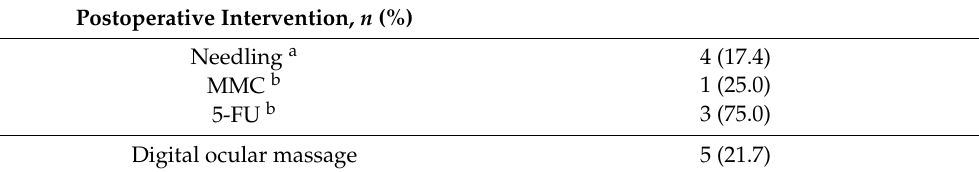
Table 3. Overview of the postoperative interventions over the course of the study